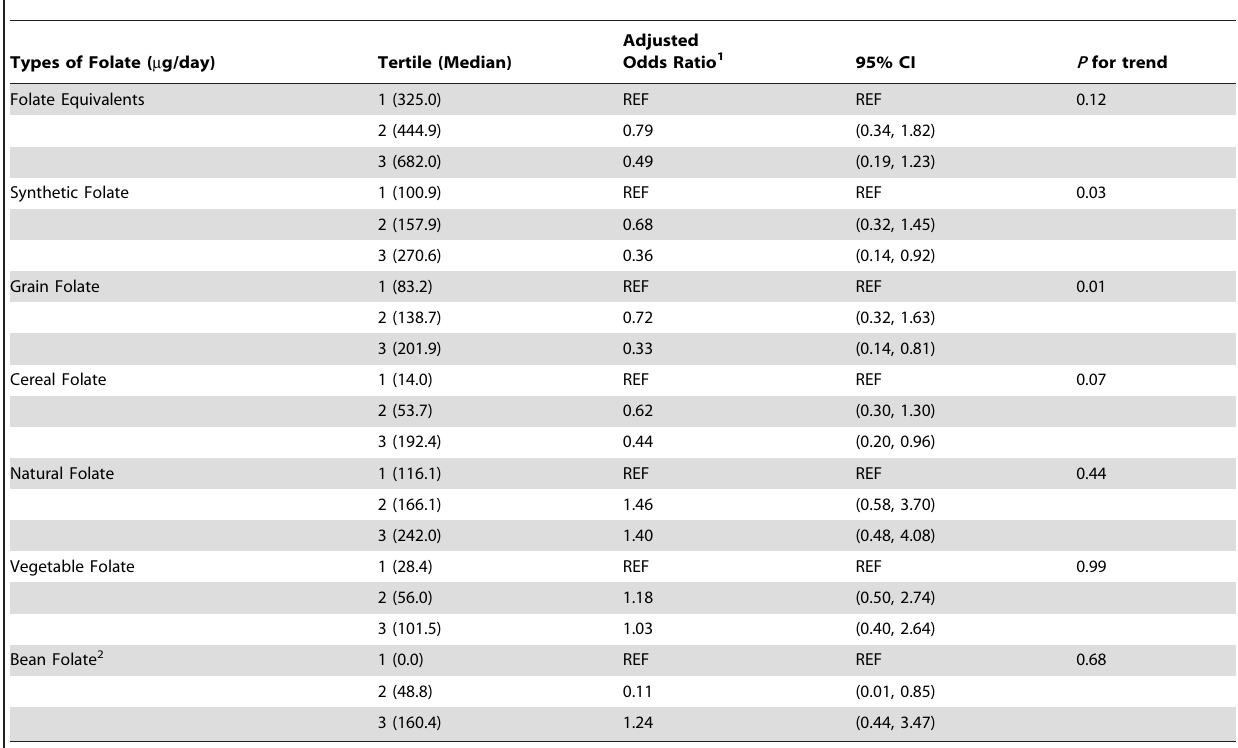
Table 4. Association between dietary folate in tertiles and sporadic anovulation in the BioCycle study.